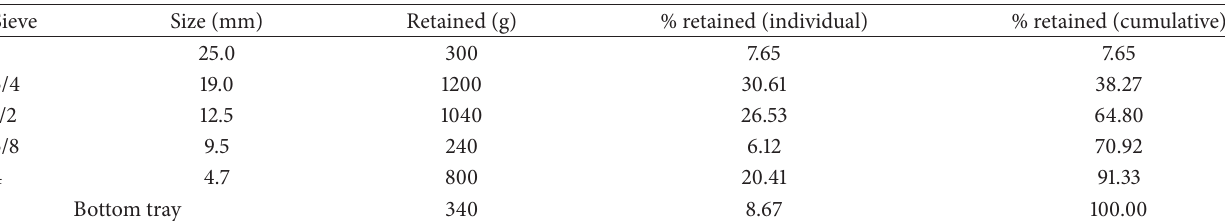
Table 3: Sieve analysis of gravel (maximum size =